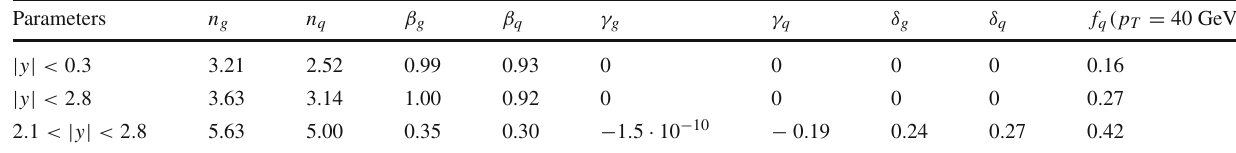
Table 4 List of parameters from the extended power law characterization of input parton spectra for “vacuum 1” configuration Parameters n g n q β g β